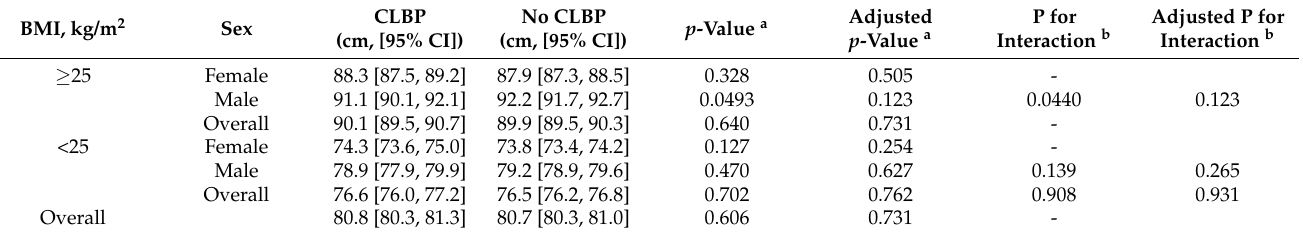
Table 2. Estimated Marginal Average of Waist Circumference According to CLBP